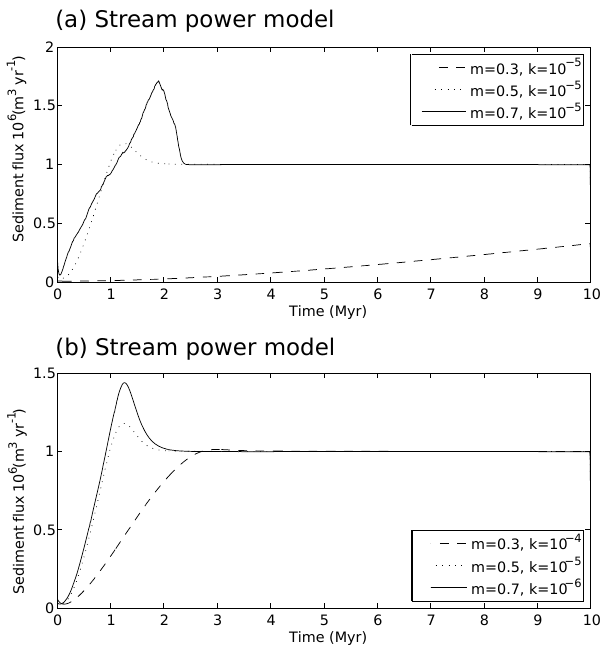
Figure 4. Sediment flux out of the model domain for the stream power models in which (a) m = 0 . 3, 0.5, and 0.7 and k = 10 − 5 (m 2 yr − 1 ) 1 − m ; (b) m = 0 . 3, 0.5, and 0.7 and k = 10 − 4 , 10 − 5 , and 10 − 6 m − 1 (m 2 yr − 1 ) 1 − m